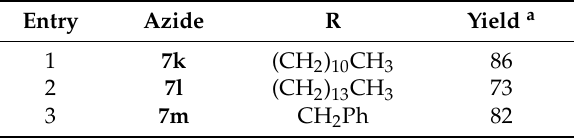
Table 2. Synthesized azides 7k – 7m